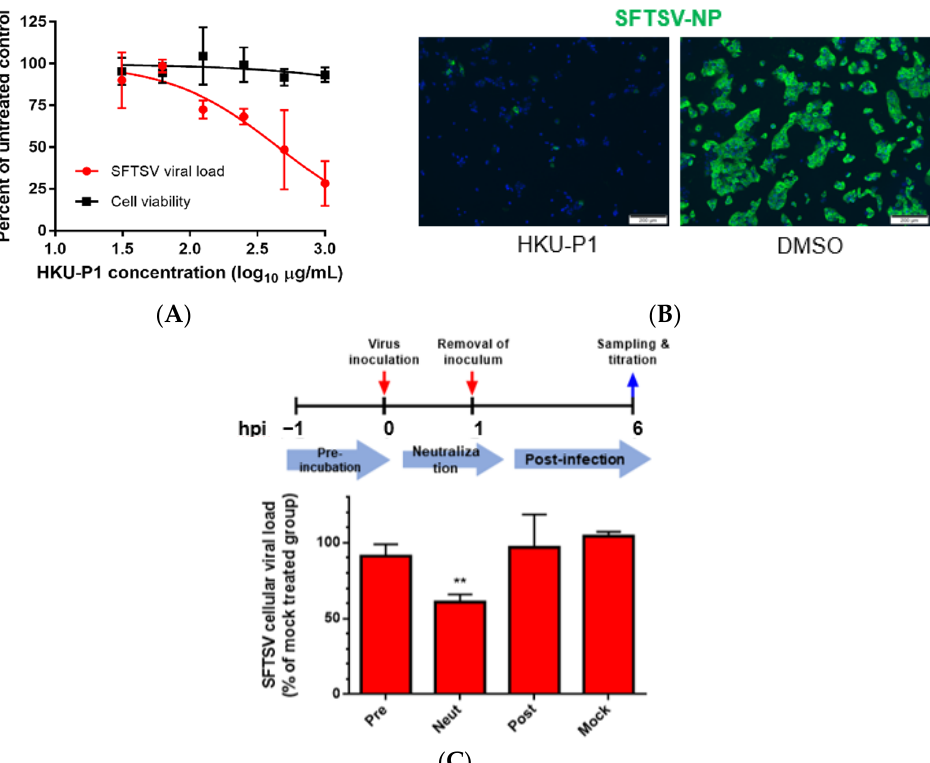
Figure 3. The anti-SFTSV activity and mode of action of cyclic peptide HKU-P1. ( A ) Evaluation of the in vitro anti-SFTSV activity and cell toxicity of HKU-P1. The SFTSV intracellular viral RNA load at 1 day post infection (MOI = 0.01) in Huh-7 cells with HKU-P1 was quantified by RT-qPCR. Cell viability was determined at the same condition using CellTiter-Glo assay. SFTSV viral RNA load was normalized as % of the mock-treated control group. HKU-P1 displayed dose-dependent reduction of the SFTSV viral RNA load with >80% ( p = 0.010) viral RNA load reduction being achieved at 1000 µg/mL of HKU-P1. The half-maximal inhibitory concentration (IC 50 ) was calculated using non-linear regression analysis in GraphPad Prism. ( B ) Immunofluorescence staining of SFTSV-NP in virus-infected Huh-7 cells treated with HKU-P1. ( C ) Time-of-drug-addition assay was performed to determine the step in the SFTSV replication cycle that is interrupted by HKU-P1. HKU-P1 was either pre-incubated with Huh-7 cells at 1h pre-infection (Pre), co-incubated with SFTSV during virus entry (Neut), or added at 1 h post-infection (Post). The viral RNA load was normalized as % of mock-treated control group. Significant viral load reduction was observed in the neutralization group. This was compatible with the postulated mechanism of the cyclic peptides as they were designed as SFTSV-Gn binders. ** denotes p < 0.01 (compared to the mock-treated control group with Student’s t-test). Data are presented as mean values ± standard deviations ( n = 3). All experiments were performed in triplicate and repeated twice for